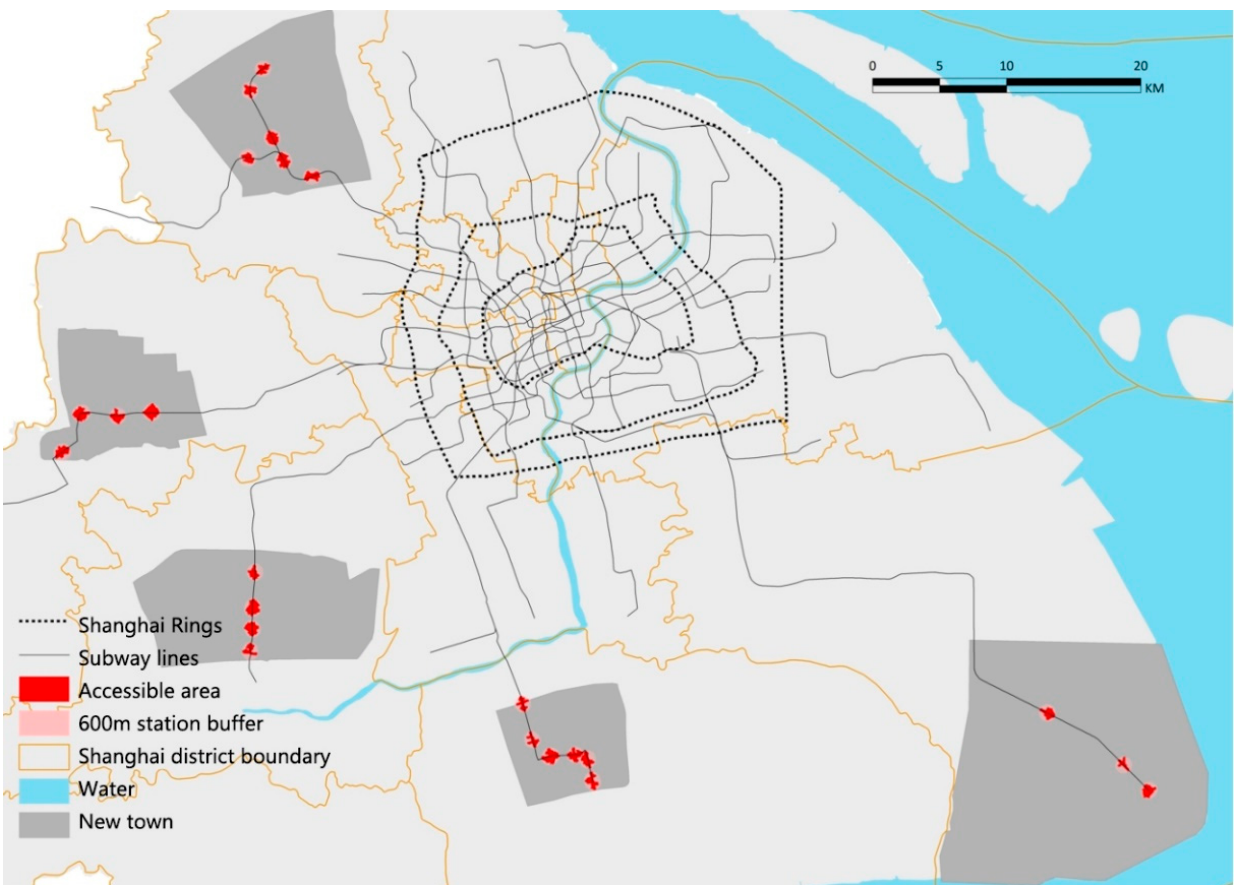
Figure 2. Study area.